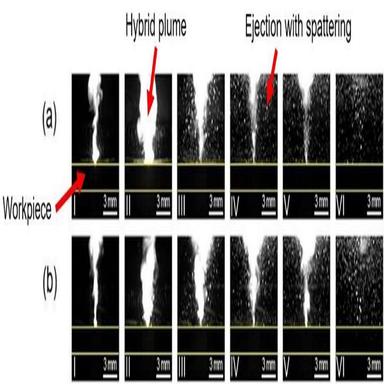
High-speed camera images showing the transient evolution of the blind-hole drilling stage using the first laser pulse (a) without and (b) using water-based ultrasonic assistance.